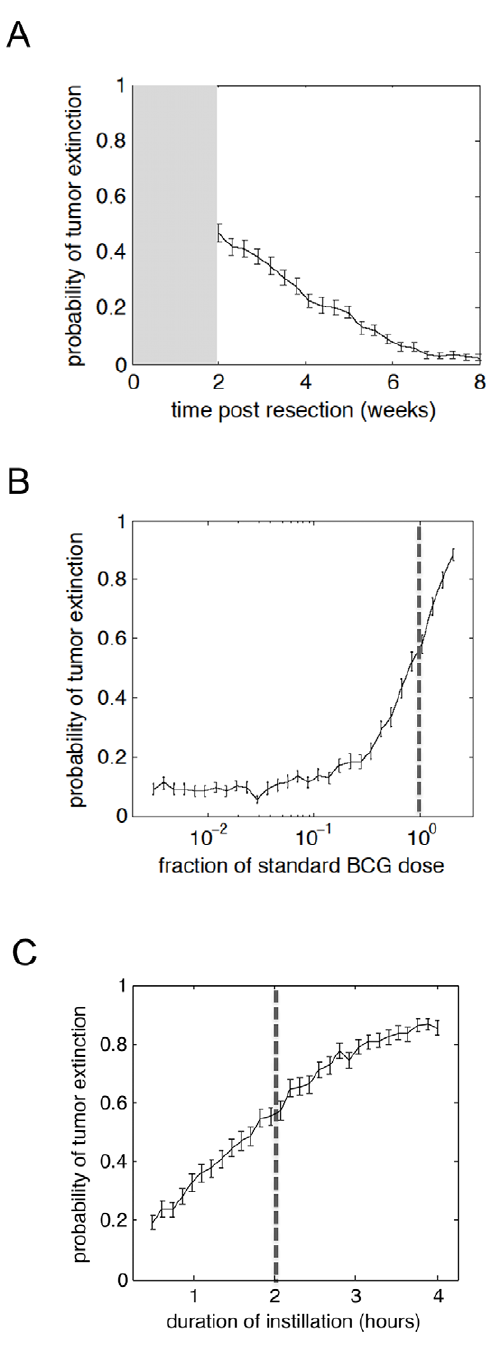
Figure 2. Timing of BCG therapy, BCG dose and dwell time influence probability of tumor extinction. ( A ) Probability of tumor extinction with varying the time from surgery to the start of BCG therapy. The grey shaded area represents the time from surgery to the typical initiation of BCG therapy (i.e., 2 weeks). The cancer growth rate used is based on the clinical observation that high-grade lesions become visible by 3 months in the absence of treatment (detailed definition of tumor dynamics is provided in the supplementary information and Figure S2 ). The probability of tumor extinction after six weekly BCG instillations was modeled as a function of ( B ) BCG dose, and ( C ) BCG dwell time.